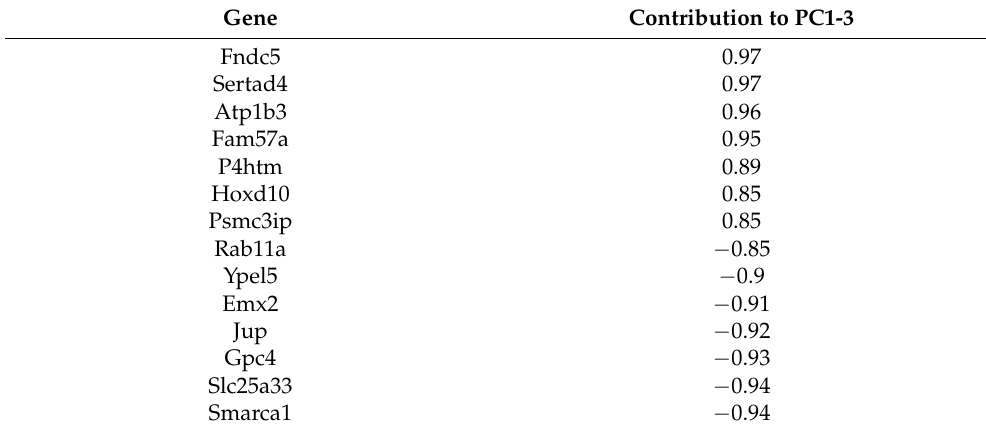
Figure 8. Three-dimensional distribution of samples based on PC1, PC2, and PC3. Black solid points and hollow points mean Inha − / − with and without hCG samples, and solid and hollow triangles mean WT with and without hCG samples. Table 6. Gene contributions to